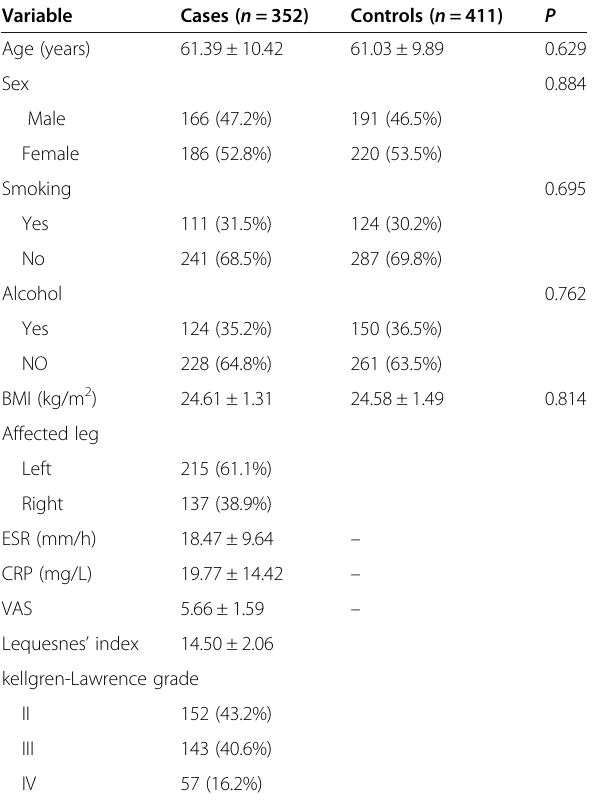
Table 1 The general characteristics of study